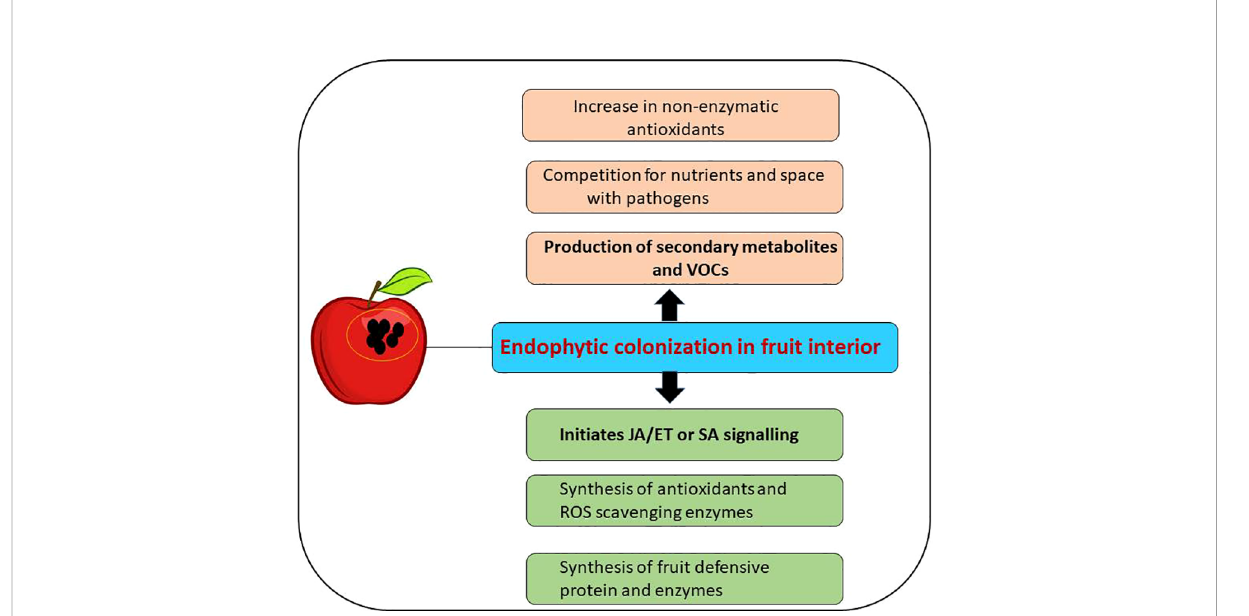
FIGURE 3 Activation of induced systemic resistance (ISR) signaling pathway and production of bioactive secondary metabolites after colonization of endophytes in the host (postharvested